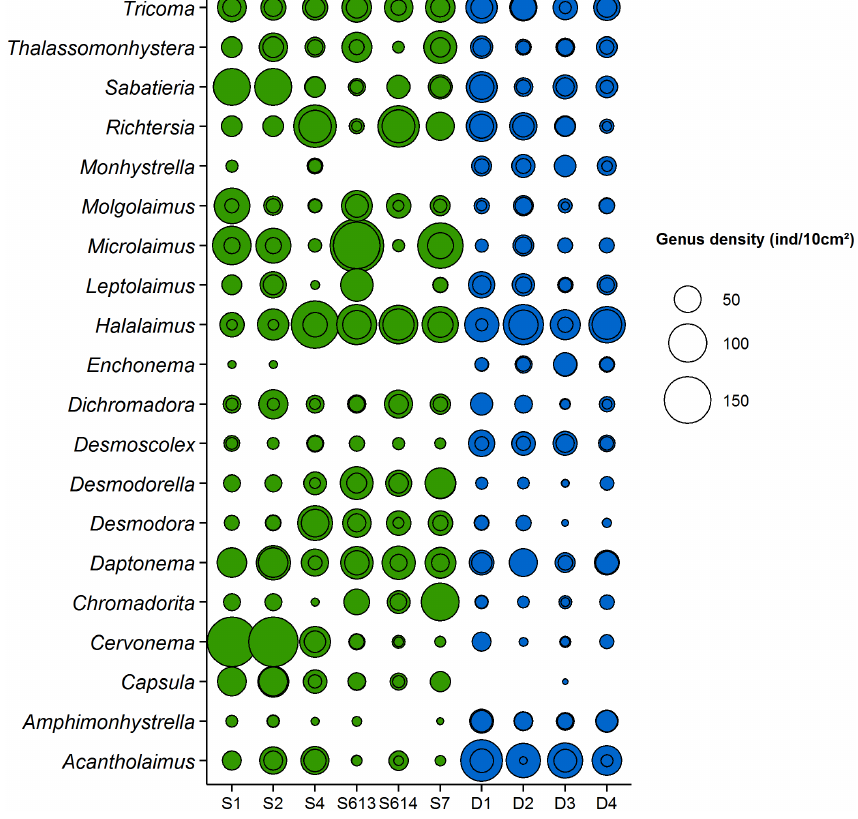
Figure 3. Most abundant nematode genera (>4%) per station. Inner circles indicate genus density (10cm 2 ) and outer circles genus standard deviation. Green circles represent shallow stations and blue circles deep